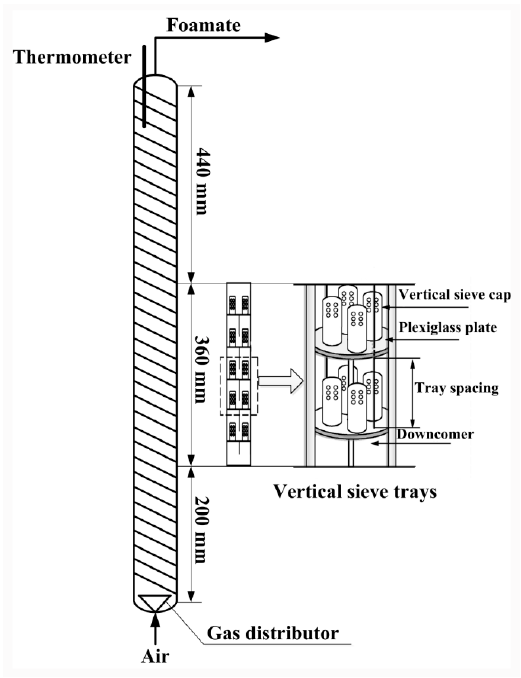
Figure 1. Schematic diagram of the foam fractionation column with vertical sieve trays.